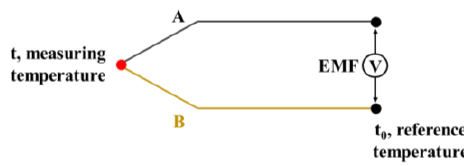
Figure 2. A typical arrangement of thermocouple.